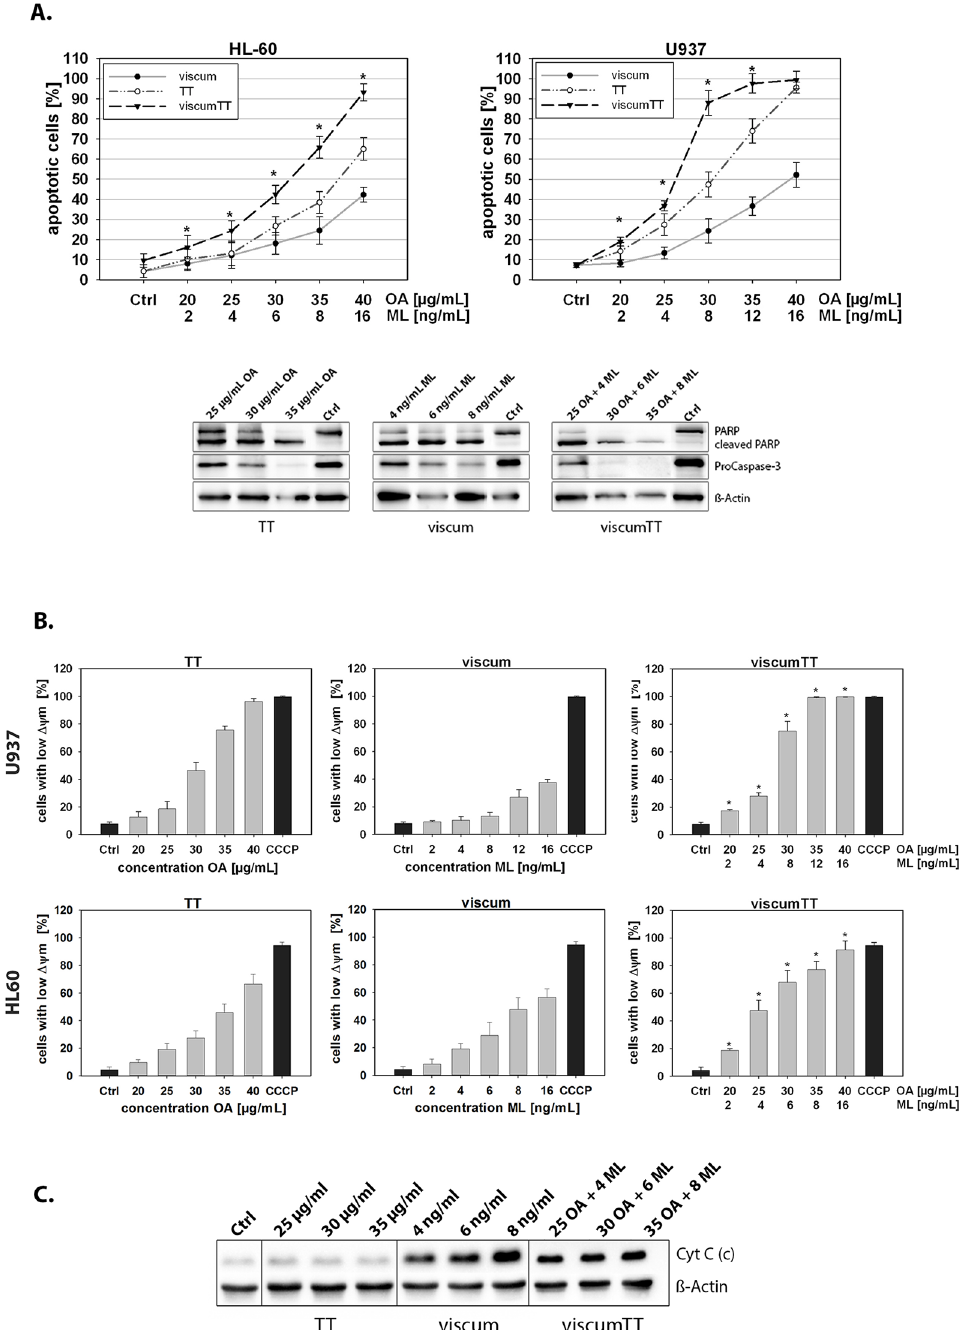
Fig 2. Triterpene acid- and lectin-containing extracts induce apoptosis in leukaemia cells. A. To measure the induction of apoptosis by VAE, U937 and HL-60 cells were treated with different concentrations of the extracts for 18 h. Apoptosis was determined with Annexin V-APC and propidium iodide by flow cytometry. Values are given as percentages of Annexin V-positive/PI-negative cells ( ± SD, n = 3). The results indicate a dose-dependent induction of apoptosis. Webb´s fractional product was used to calculate the additive, antagonistic or synergistic effect of the combination viscumTT. A single asterisk indicates Fp > 1 and reveals a synergistic effect of viscumTT when compared to the single agents TT and viscum. Fp = fractional product. To confirm apoptosis induction after VAE treatment, whole cell lysates of VAE-treated HL-60 cells were separated by SDS-PAGE followed by Western blotting and decrease of procaspase-3 and cleavage of PARP was detected. Equal loading was verified using ß-actin as internal protein control. The blots are representative of three independent experiments. B. VAEs induce mitochondrial membrane permeability. U937 and HL-60 cells were incubated with TT, viscum or viscumTT for 18 h. After incubation, the mitochondrial permeability transition was measured by JC-1 and flow cytometric analysis on single cell level. Values of mitochondrial permeability transition are given in percentages of cells with low mitochondrial potential ( ΔΨ m ) ± SD, n = 3. A single asterisk